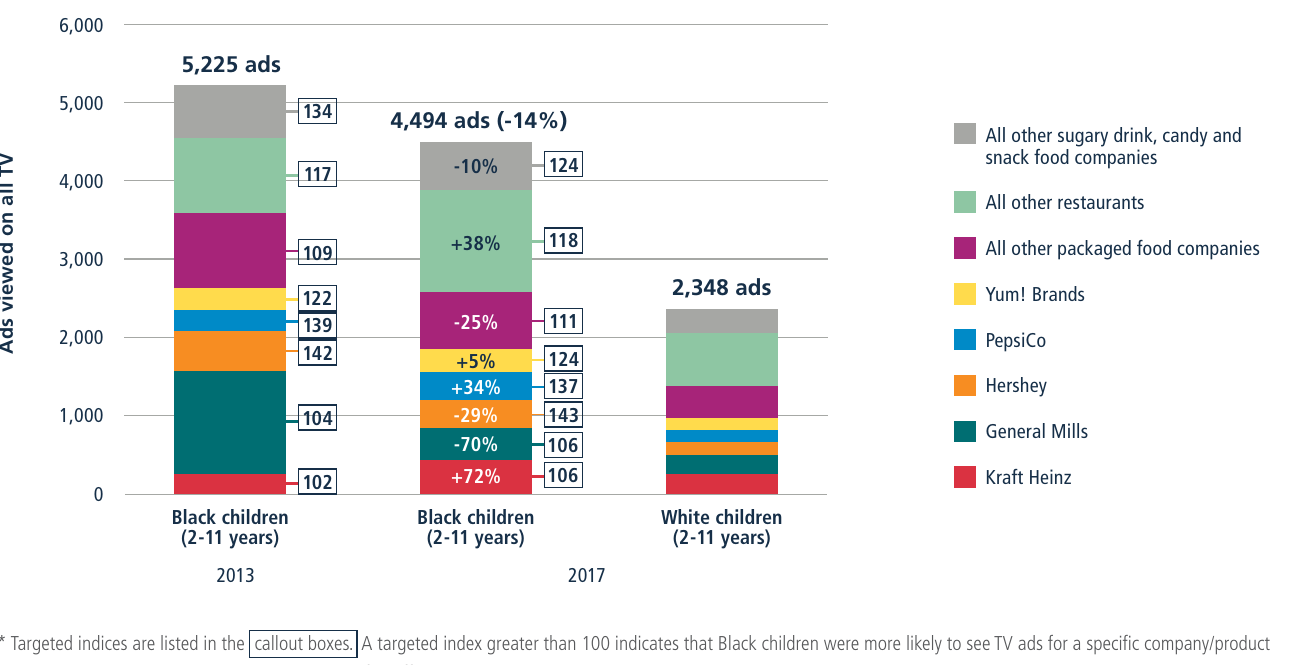
FIGURE 9. BLACK AND WHITE CHILDREN’S EXPOSURE TO ADVERTISING ON ALL TV PROGRAMMING BY